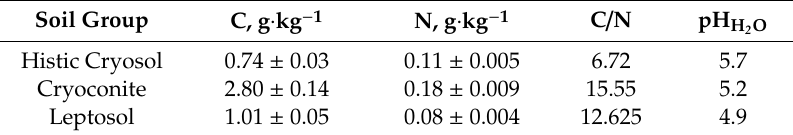
Table 3. The basic chemical characteristic of study soil with ±